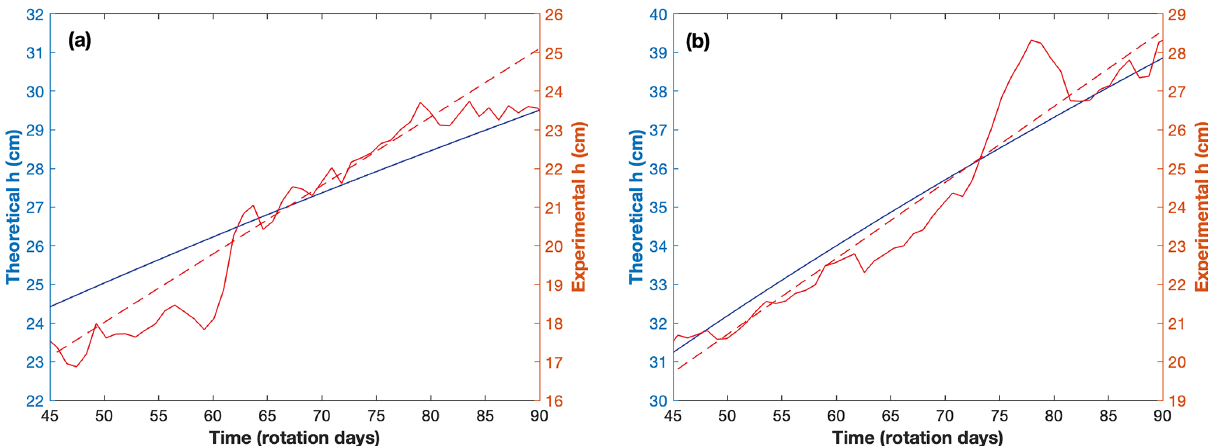
Figure 4. Evolution of the lower-layer thickness during Phase II: experimental data from vertical profiling at Cp3 (continuous red line), the linear regression curve (dashed line), and the theoretical values obtained from Eq. (4) (see text, blue line). EXP 24 is shown in panel (a) , and EXP 27 is shown in panel (b) .